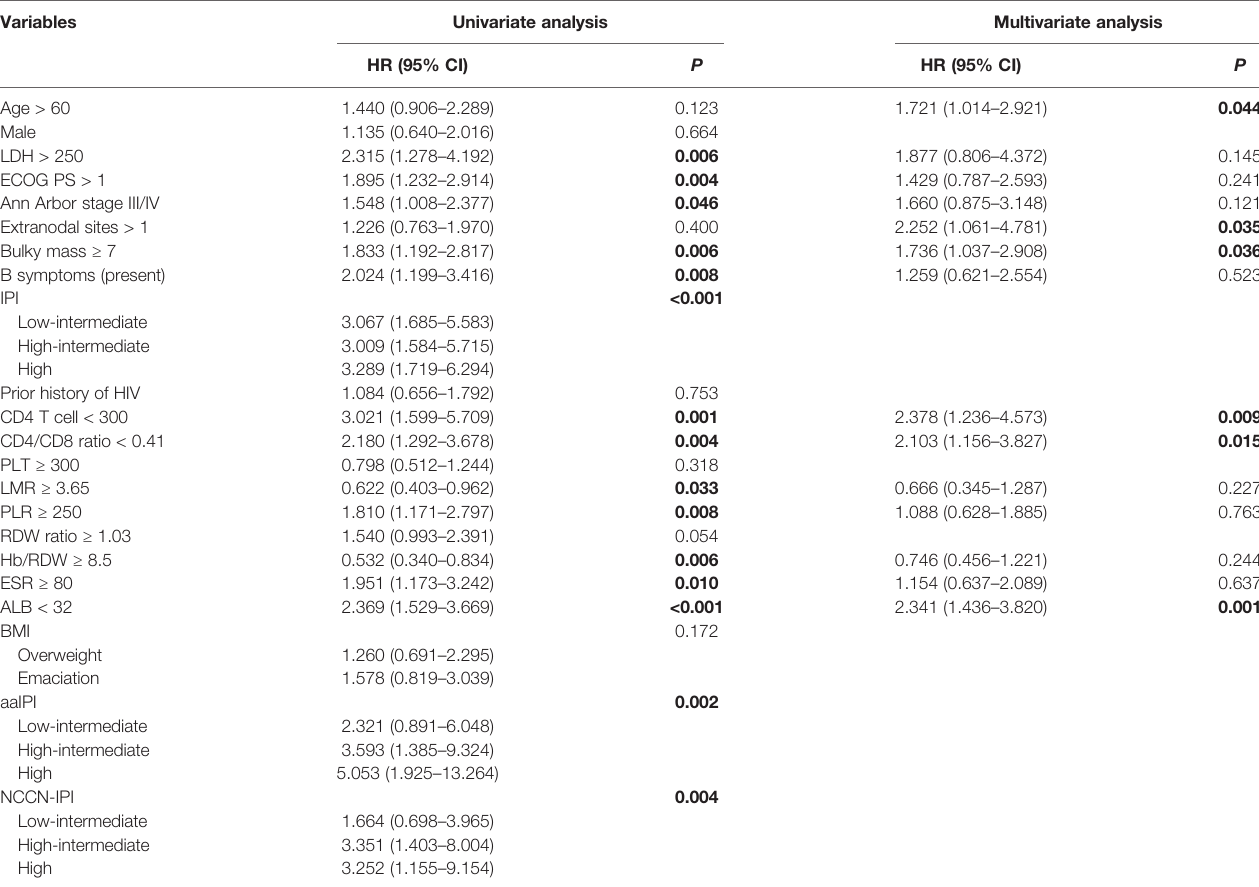
TABLE 2 | The factors associated with 3-year overall survival in AIDS-related lymphoma patients ( n = 138).